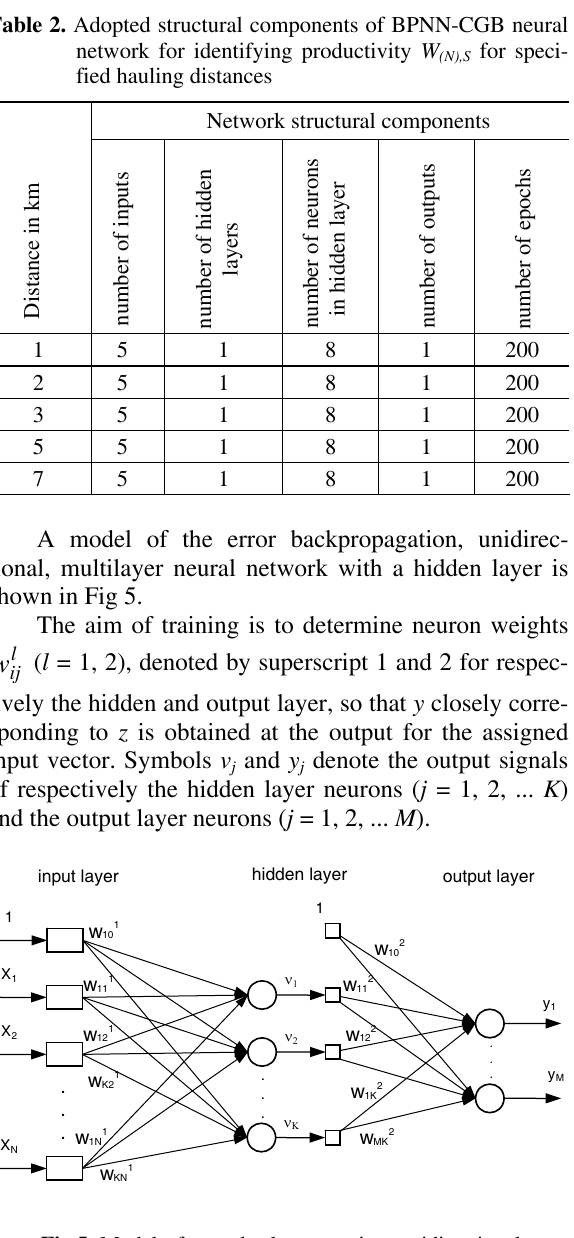
Fig 5 . Model of error backpropagation, unidirectional two- layer neural network with one hidden layer [8,